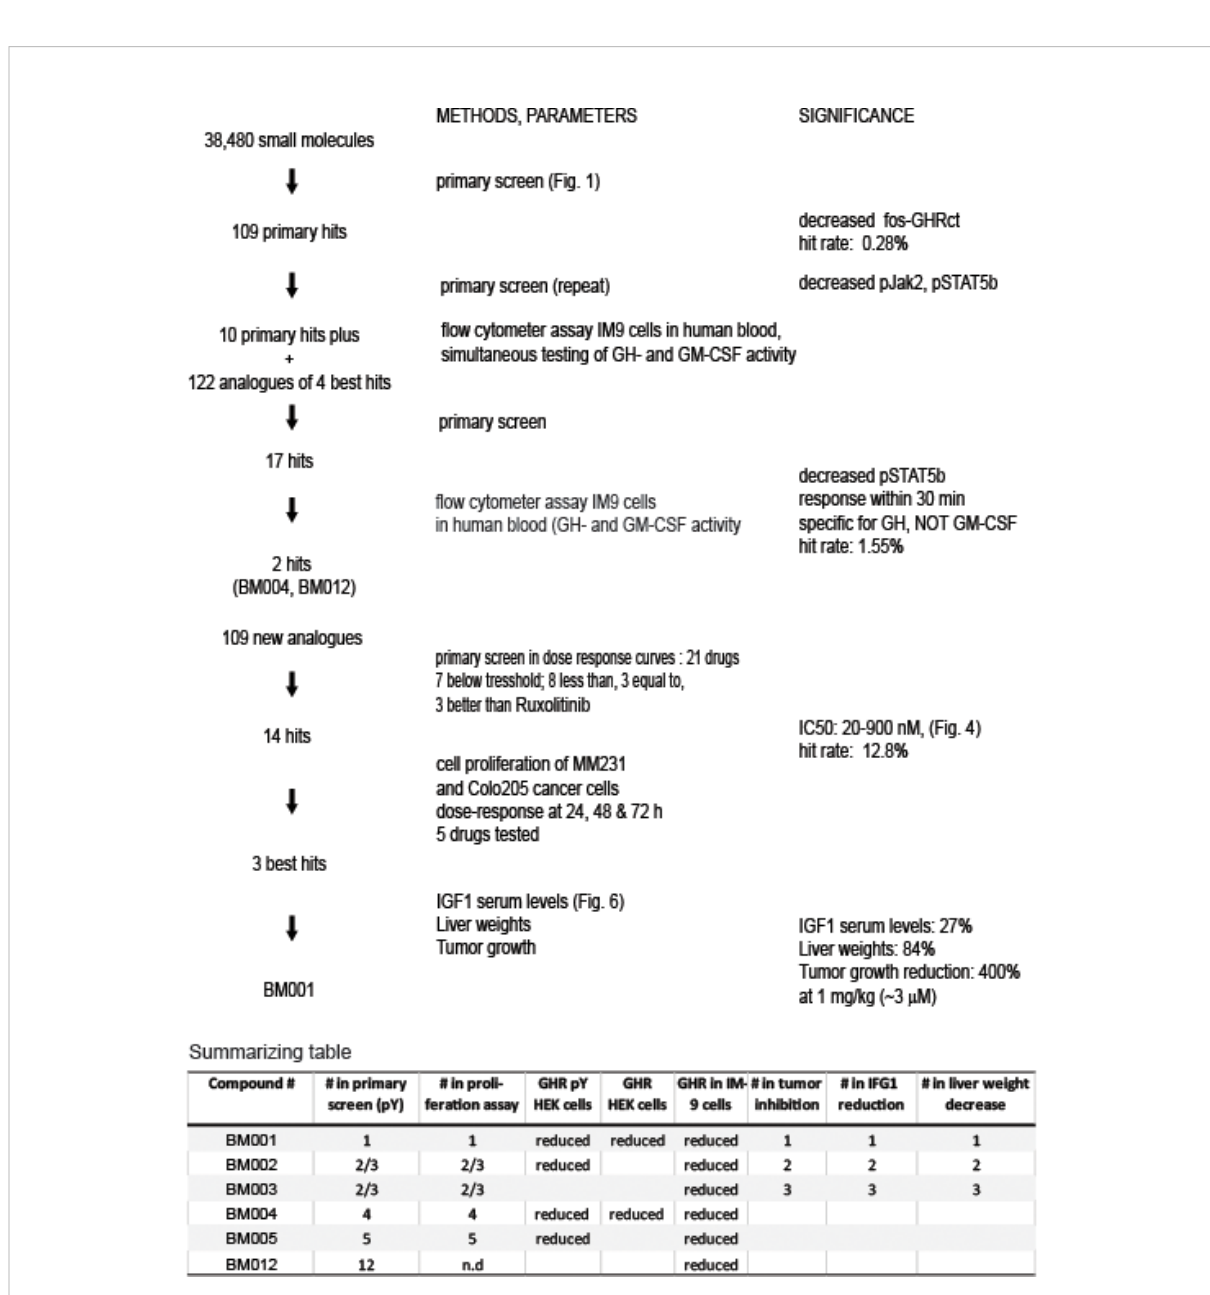
FIGURE 3 Drug discovery scheme of GH/IGF1 axis inhibitors with the key steps . The last three columns of the summarizing table are explained in Figure 4